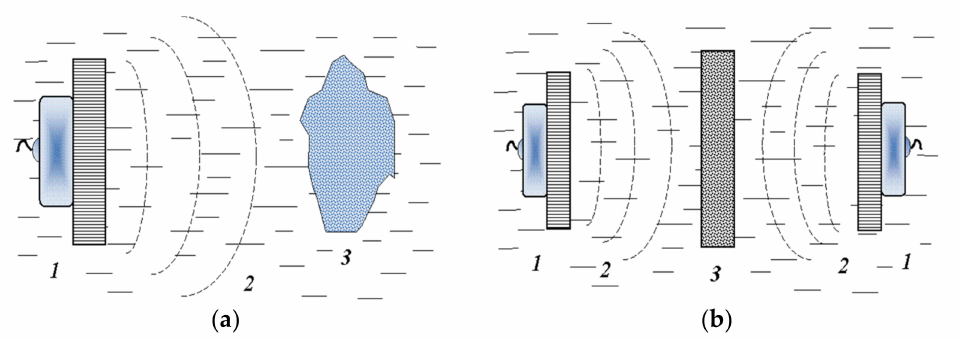
Figure 2. Possible schemes of erosive action on solid particles with ultrasonic cavitation assistance: 1— ultrasonic emitter; 2—ultrasonic wave; 3—target; ( a )—running ultrasonic wave usage; ( b )—standing ultrasonic wave